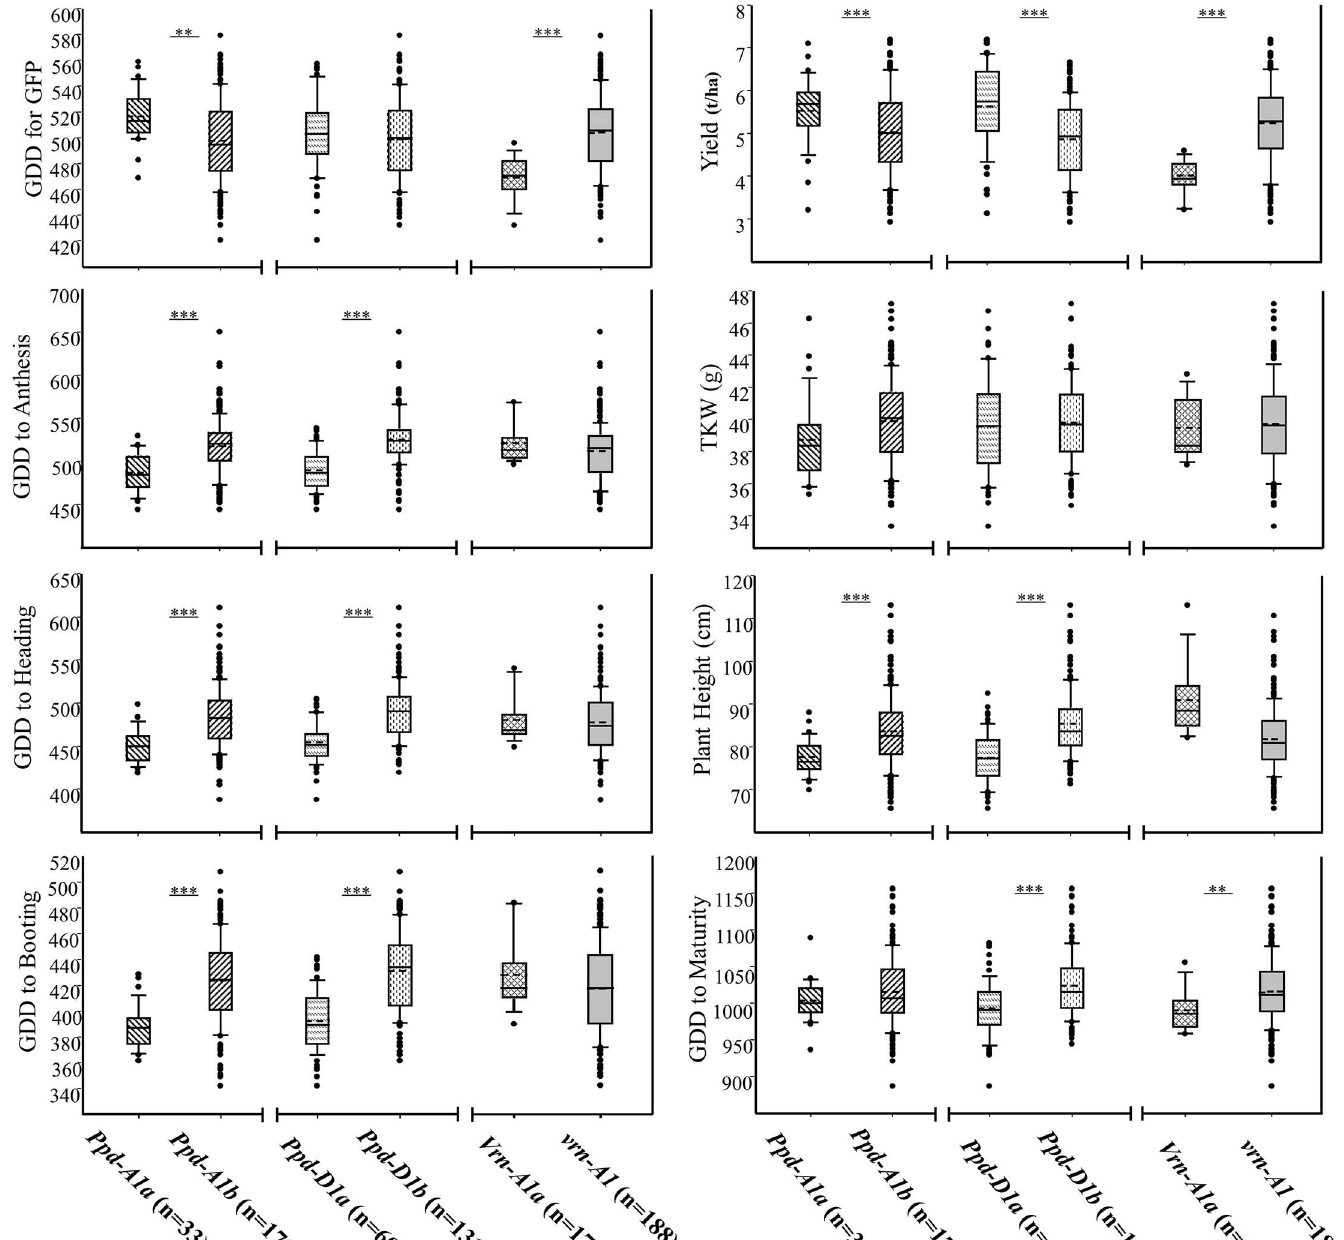
Fig 2. Box plots representing the frequency distribution of genotypes in three Ppd-A1 , Ppd-D1 and Vrn-A1 genotypic groups for phenotypic traits observed in the field trials during 2015 and 2016 in Ontario, Canada. (cid:3) , (cid:3)(cid:3) , and (cid:3)(cid:3)(cid:3) represent significant differences at 0.05, 0.01, and 0.001, respectively. n = Number of genotypes in each group. In each box-plot, solid dots represent outliers. Each box represents the interquartile range, which contains 50% of the values. The whiskers are lines that extend from the box to the highest and lowest values, excluding outliers. The dashed and solid lines across the box indicate the median and mean, respectively. GDD: Growing Degree Days. TKW: Thousand-Kernel Weight (g). GFP: Grain Filling Period. The effect of allelic variation at the PPD-D1 locus was not significant for GDD required for GFP (Table 3, Fig 2). Genotypes with different alleles at the PPD-A1 locus, on the other hand were significantly different for GDD required for GFP (Table 2). The average GFP of the